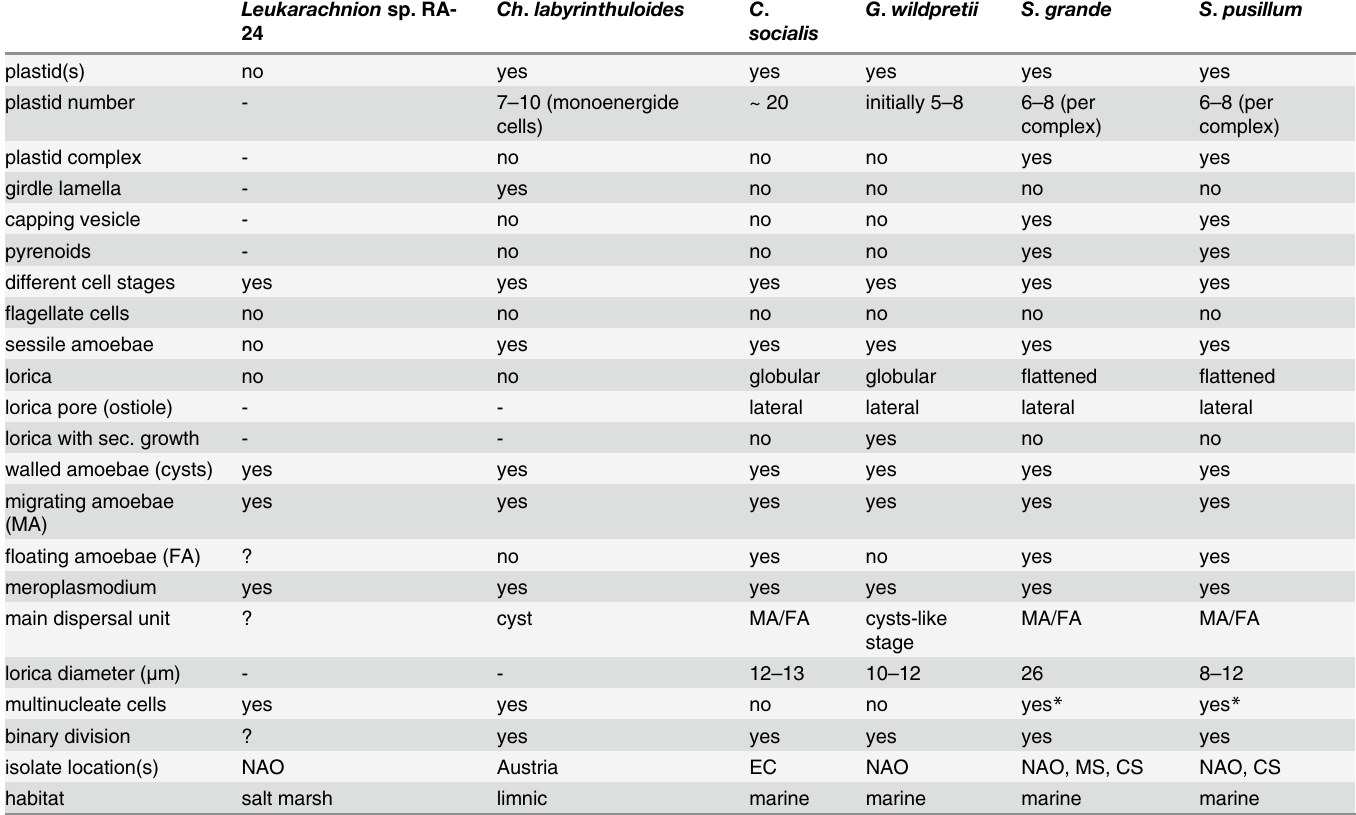
Table 1. Characteristic features of Synchromophyceae and related amoeboid algae. Features are taken from [8,9,11,14,68] and this study. NAO — North Atlantic Ocean, MS — Mediterranean Sea, CS — Caribbean Sea, EC- English Channel. Leukarachnion sp. RA-